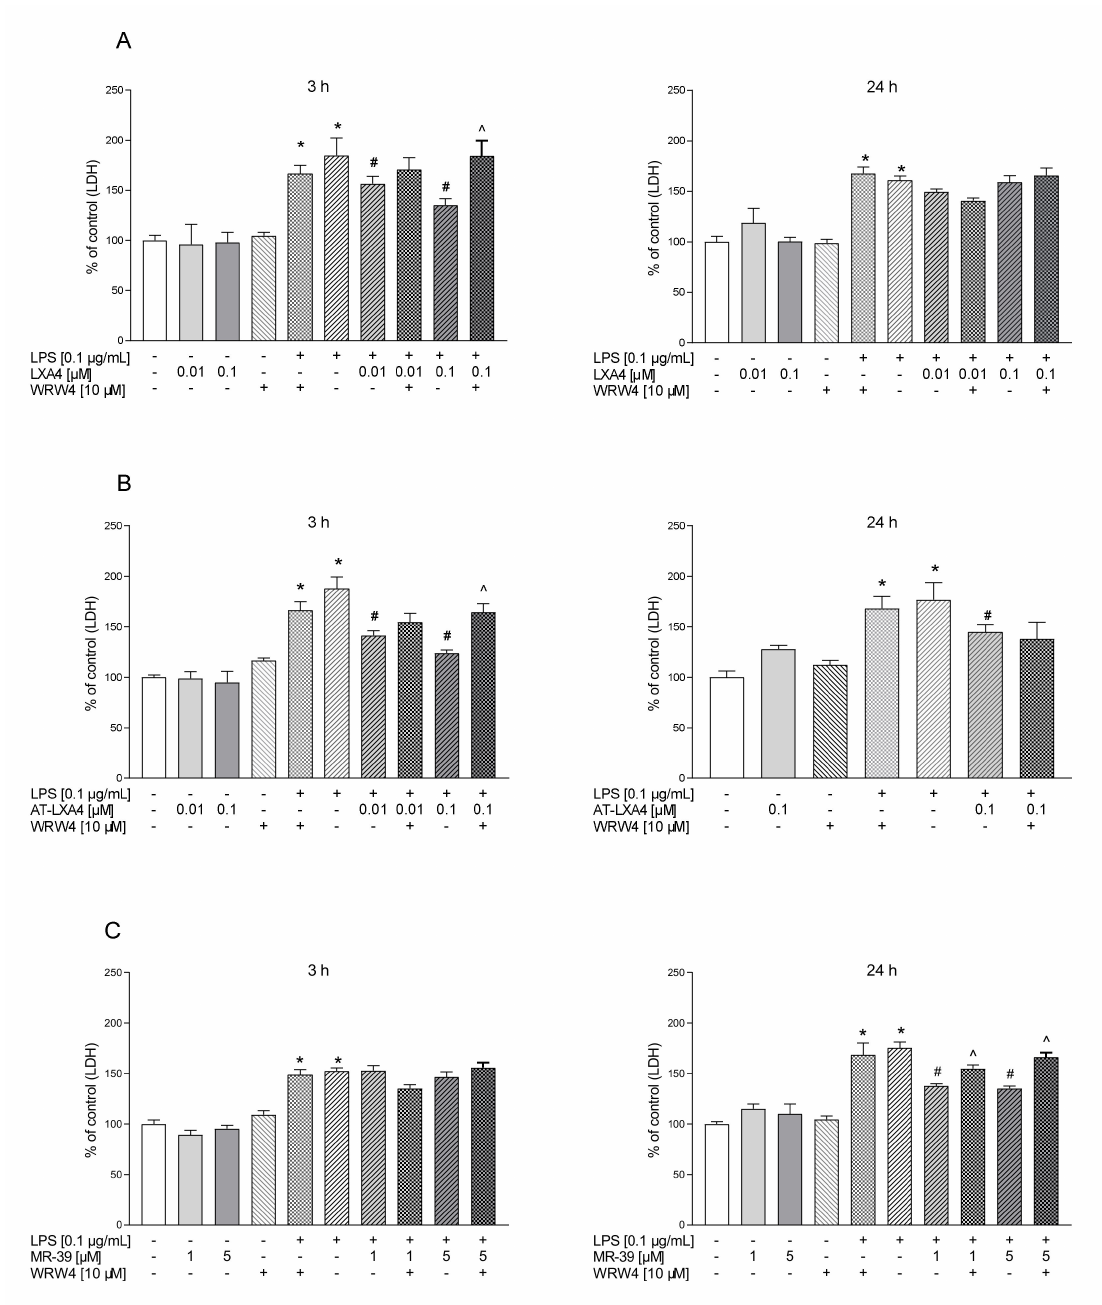
Figure 4. The time-dependent impact of LXA4 ( A ), AT-LXA4 ( B ), and MR-39 ( C ) on LPS-induced LDH release in rat microglial cultures. The cells were pretreated for 30 min with the FPR2 antagonist WRW4 (10 µ M). After that, LXA4 (0.01 µ M or 0.1 µ M), AT-LXA4 (0.01 µ M or 0.1 µ M), or MR-39 (1 or 5 µ M) was added for 1 h, and then the cells were stimulated for 3 or 24 h with lipopolysaccharide (LPS; 0.1 µ g/mL). Control cultures were treated with the appropriate vehicle. The data are presented as the mean ± SEM percentage of the control (vehicle-treated cells) of independent experiments, n = 2–5 in each experiment. * p < 0.05 vs. the control group, # p < 0.05 vs. the LPS group, ˆ p < 0.05 vs. the agonist + LPS group. LXA4–lipoxin A4; AT-LXA4–aspirin-triggered lipoxin A4; LPS–lipopolysaccharide; LDH–lactate